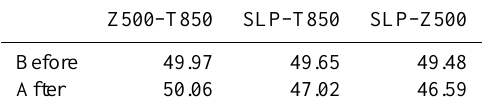
Table 8. Explained variance by the clusters (in %) for the three CT classifications before and after the allocation process.